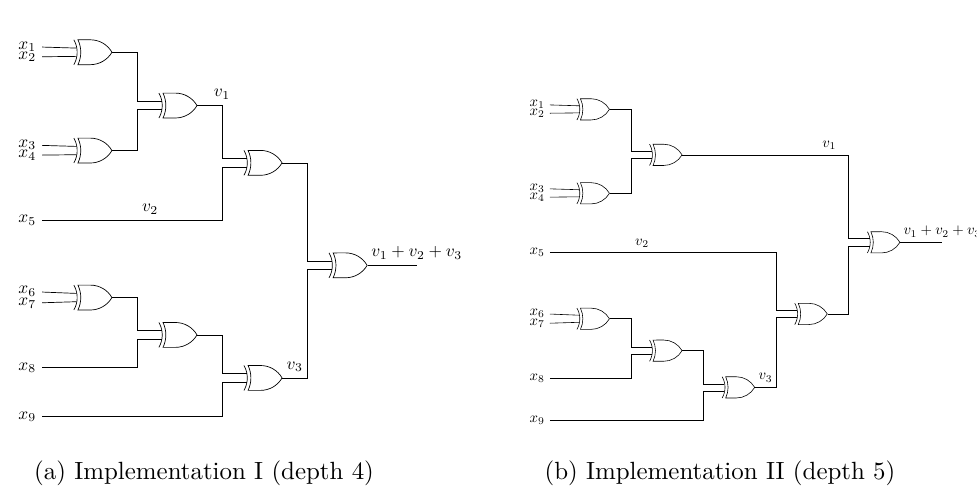
Figure 1: Two implementations of the same summation v 1 + v 2 + v 3 with different circuit depths, where the depths of v 1 , v 2 and v 3 are 2, 0, and 3 respectively. where x 8 computes f , whose depth is